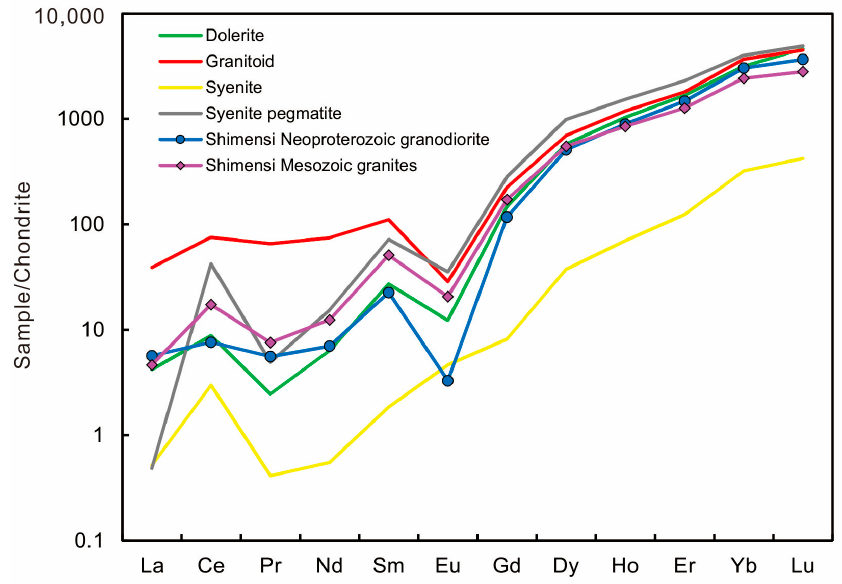
Figure 13. Chondrite-normalized averaged zircon REE patterns for the Shimensi granodiorite. Data of the ore-related Mesozoic Shimensi granites are from Wei et al. [6]. Data of the zircons from different igneous rock types are from [49].